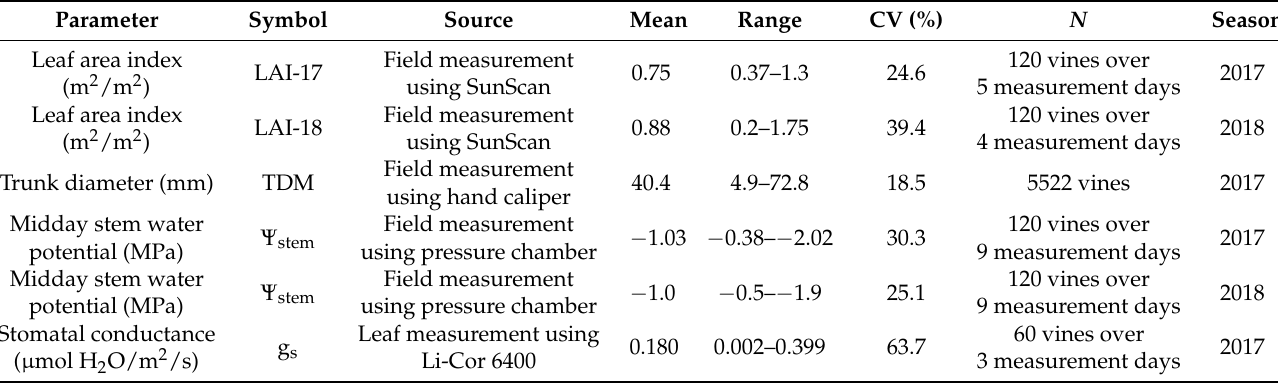
Table 3. Descriptive statistics of physiological variables. CV stands for the coefficient of variation